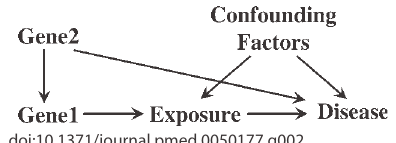
Figure 4. A Mendelian Randomisation Study Where the Chosen Instrument Is Not Directly Causal for the Exposure, But Is in Linkage Disequilibrium with Another Variant That Is